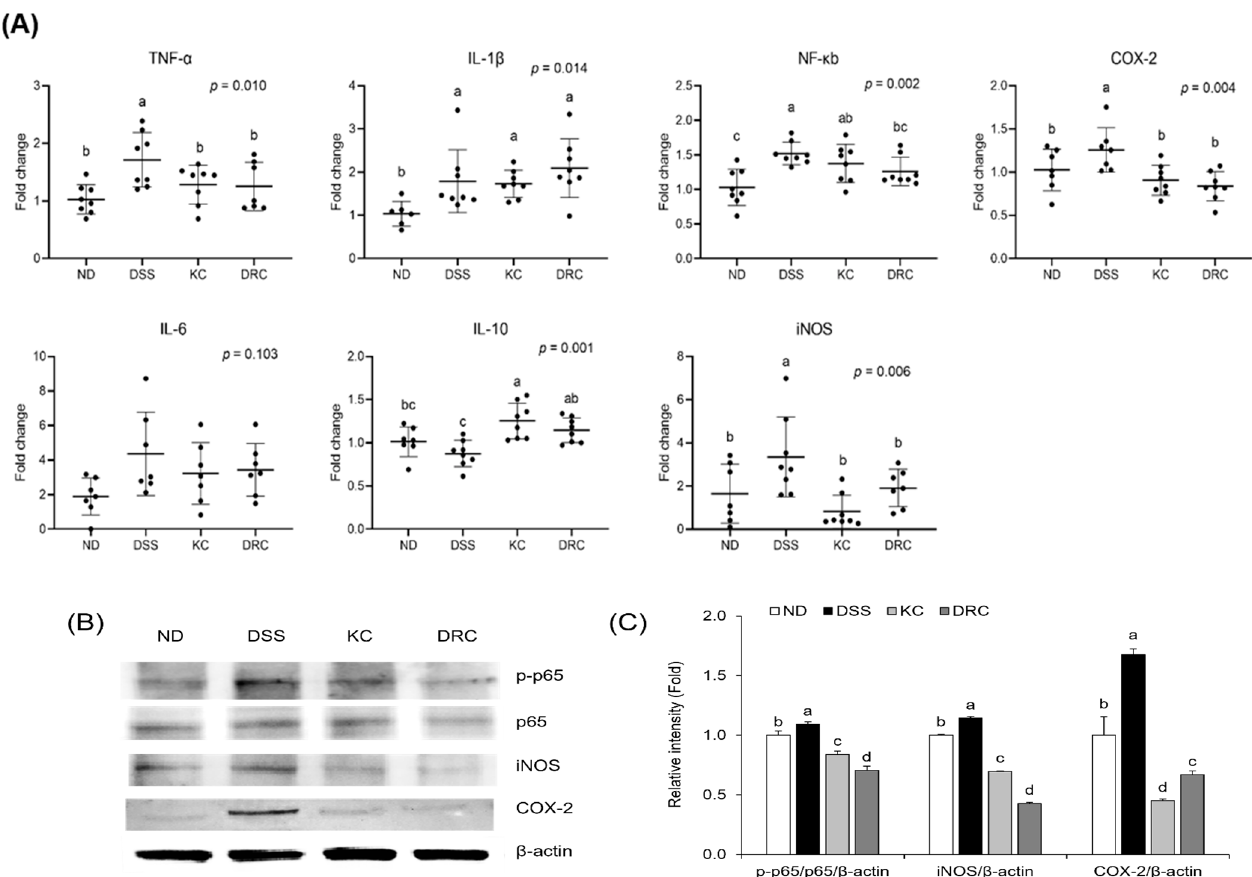
Figure 5. Effects of kimchi and Leu. mesenteroides DRC 1506 on the expression of mRNA ( A ) and protein ( B , C ) related to the pro-inflammatory factors in colon tissue. ( A ) The relative mRNA expres- sion of the target genes was quantified and normalized by β -actin. The value was expressed as fold changes with the ND group as the control. Data values are expressed as scatter plots with median, minimum, and maximum values ( n = 6–8 per group). Comparisons among groups were evaluated using one-way ANOVA with Duncan’s post hoc test. Groups with different letters had a significant difference at p < 0.05. ( B ) Representative image by Western blot. ( C ) The relative expression level of protein was quantified by Image J. The relative expression levels of protein were quantified and normalized by β -actin. The value was expressed as fold changes with the ND group as the control. Values were presented as bar graphs with means ± SD ( n = 6 per group). Comparisons among groups were analyzed by one-way ANOVA with Duncan’s post hoc test. Groups with different letters had a significant difference at p < 0.05. The presented data were from one representative experiment out of three. ND, normal group; DSS, DSS-treated group; KC, DSS + 1 × 10 9 CFU/day/mouse of kimchi group; DRC, DSS + 1 × 10 9 CFU/day/mouse of Leu. mesenteroides DRC 1506 isolated from